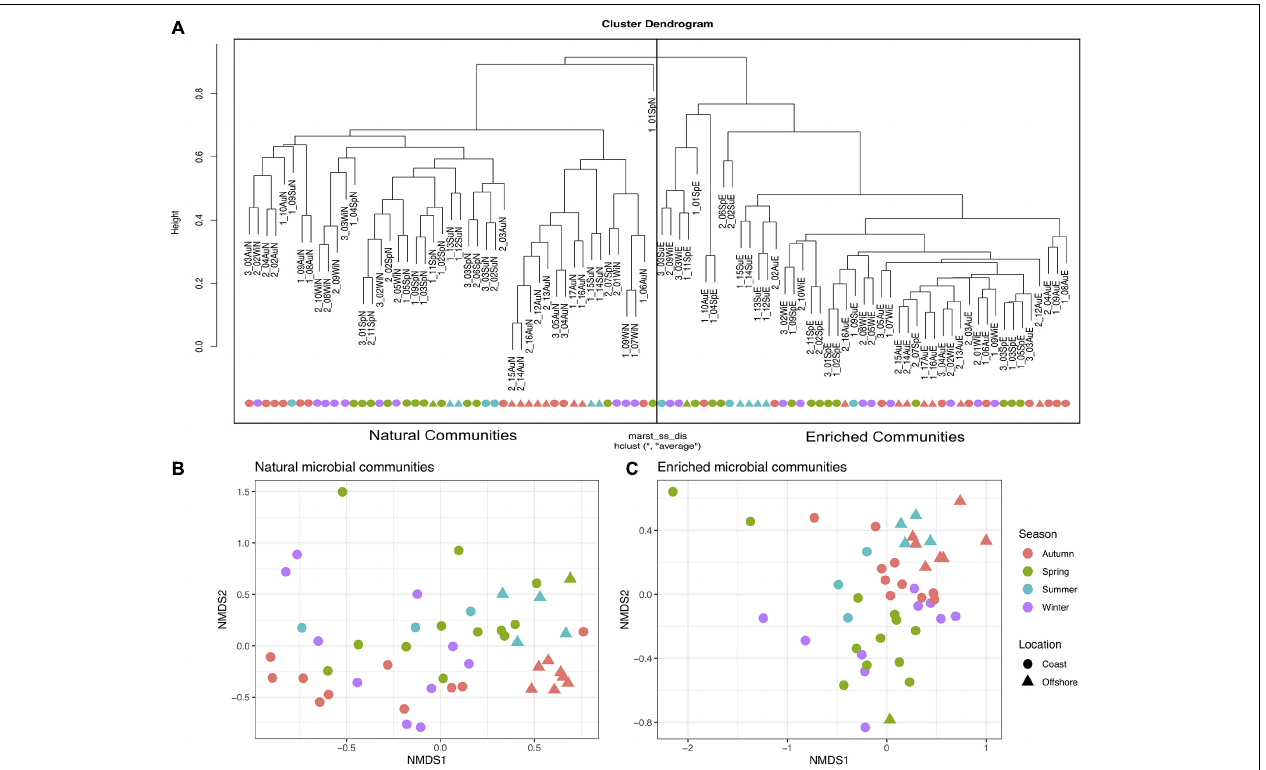
FIGURE 4 | Beta diversity analysis performed for natural and enriched microbial communities. (A) Bray-Curtis hierarchical cluster of the natural and enriched communities of all 47 sampled sites [the first number represents the sampling area (1, 2, or 3)]. (B) Non-metric multidimensional scaling (NMDS) for all 47 natural microbial communities, based on absolute abundance of ASVs, in relation to Season and Location. (C) NMDS for all 47 enriched microbial communities, based on absolute abundance of ASVs in relation to Season and Location.